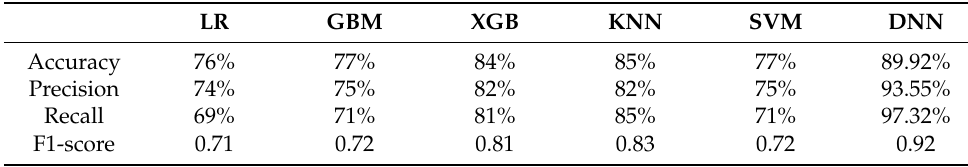
Table 2. Comparison with ML